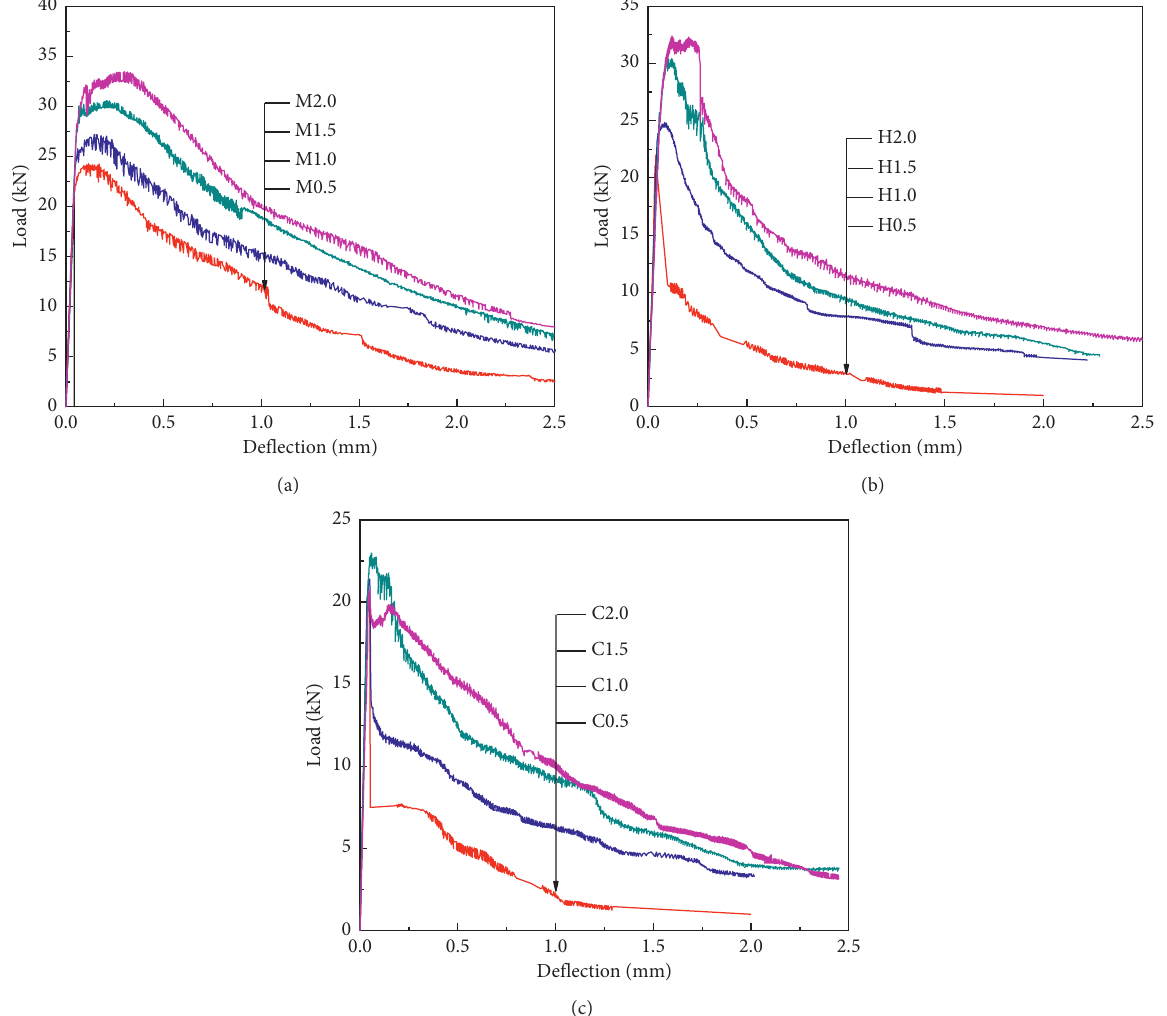
Figure 5: The load-displacement curve of three-point bending test. (a) M steel fibers. (b) H steel fibers. (c) C steel